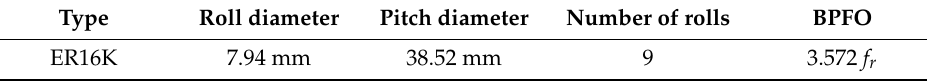
Figure 8. The test rig.